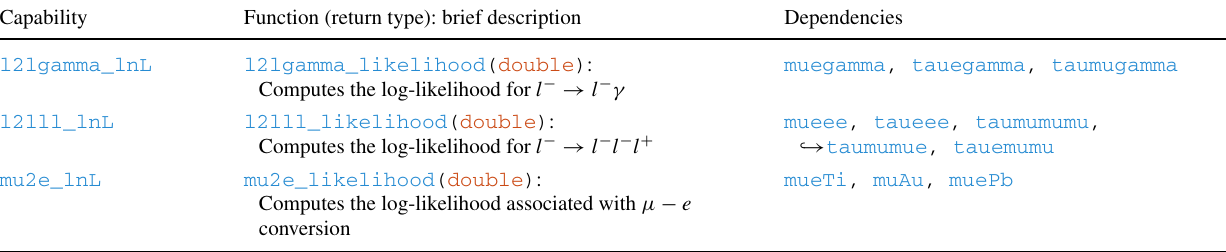
Table 12 Capabilities and module functions for the likelihoods computed for the LFV observables